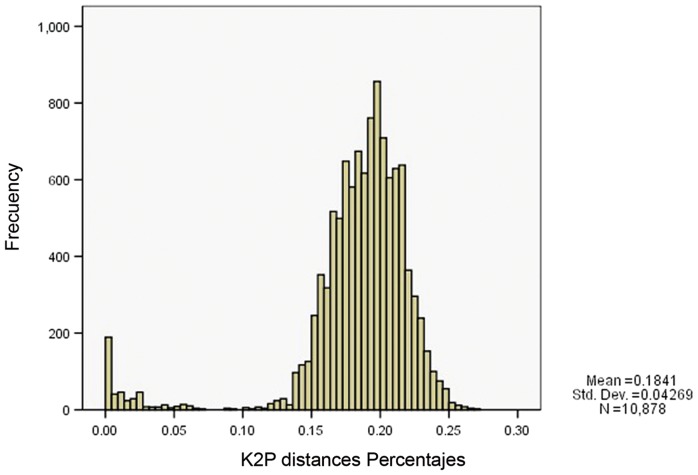
Genetic divergences (K2P distances) between COI sequences for varied taxonomic levels of Colombian sand fly species.The frequency of pairwise divergences among specimens both within species and among different species.